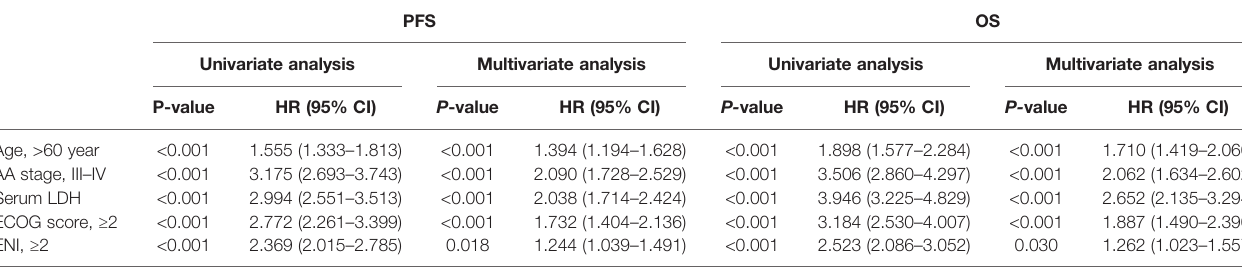
TABLE 2 | Univariate and multivariate analysis for PFS and OS of DLBCL patients (n =